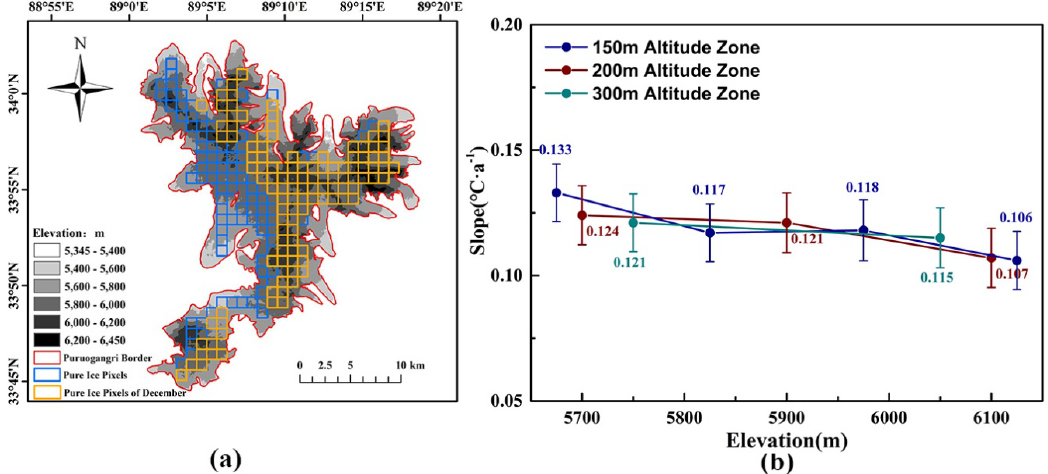
Figure 8. Variations in December LST (land surface temperature) with altitude in the Purog Kangri ice field. ( a ) The yellow grid shows the 115 temporally continuous pixels of the MODIS LST selected in December. ( b ) LST trend as a function of altitude of the ice field for three intervals: 150 m, 200 m, and 300 m. Error bars are the ± 1 standard error.